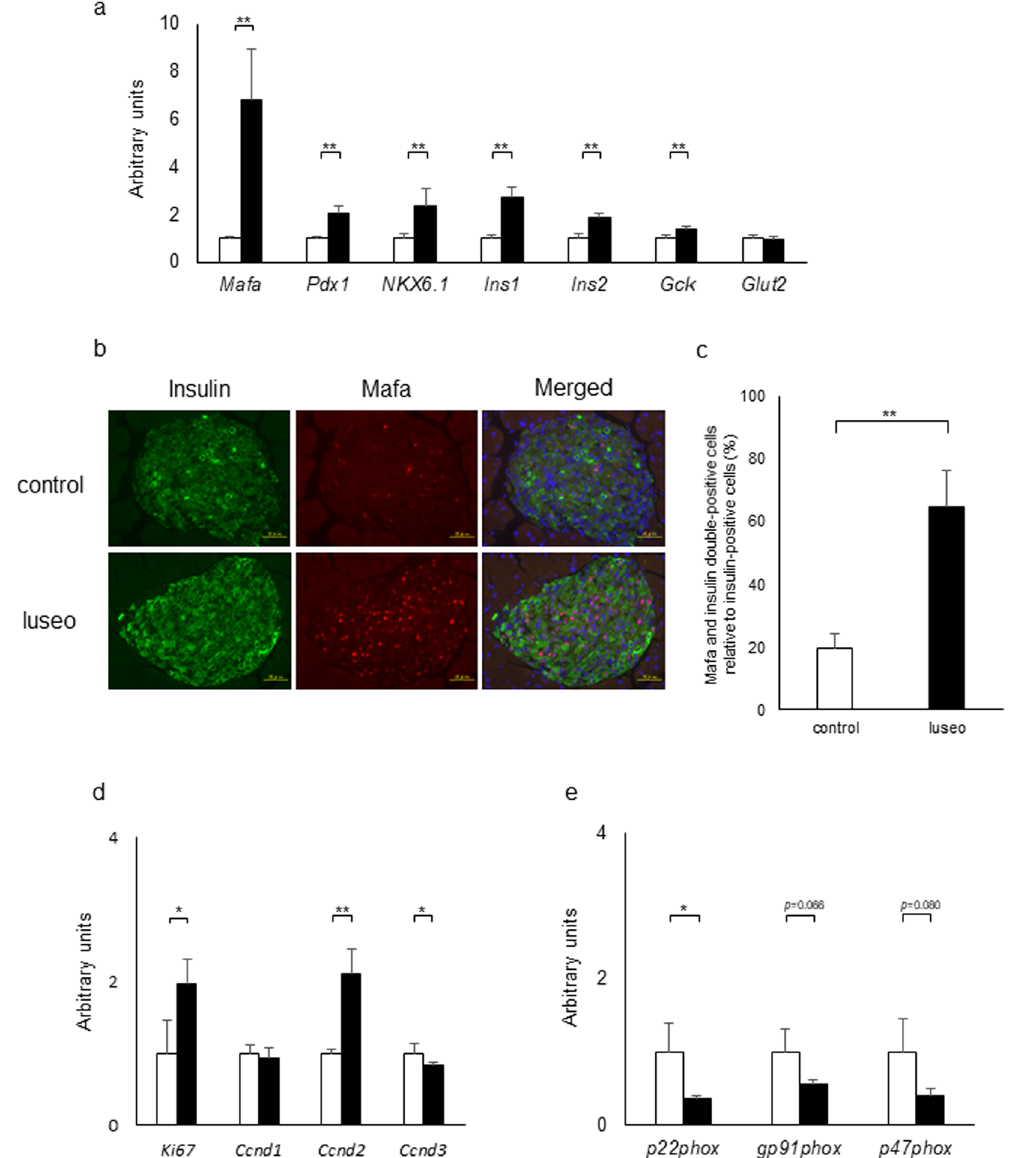
Figure 3. Changes in gene expression levels in islets of 6-week-old db/db mice with or without luseogliflozin for 4 weeks. ( a ) Gene expression levels of Mafa , Pdx1 , NKX6 . 1 , Ins1 , Ins2 , Gck and Glut2 in islets measured using real-time quantitative PCR. Data have been normalized to GAPDH expression. ( b ) Representative insulin (green) and Mafa (red) staining in pancreas sections from the control group and the luseo group. ( c ) The ratio of the number of Mafa-positive beta cells relative to the total number of beta cells in the control group (white bar) and the luseo group (black bar) ( n = 4: four mice were used in each group). ( d , e ) Gene expression levels of Ki67 , Ccnd1 , Ccnd2 , Ccnd3 , p22phox , gp91phox and p47phox in islets measured using real-time quantitative PCR. Data have been normalized to GAPDH expression. Values are mean ± SD. * p < 0.05; ** p < 0.01. Scale bars: 50 μ